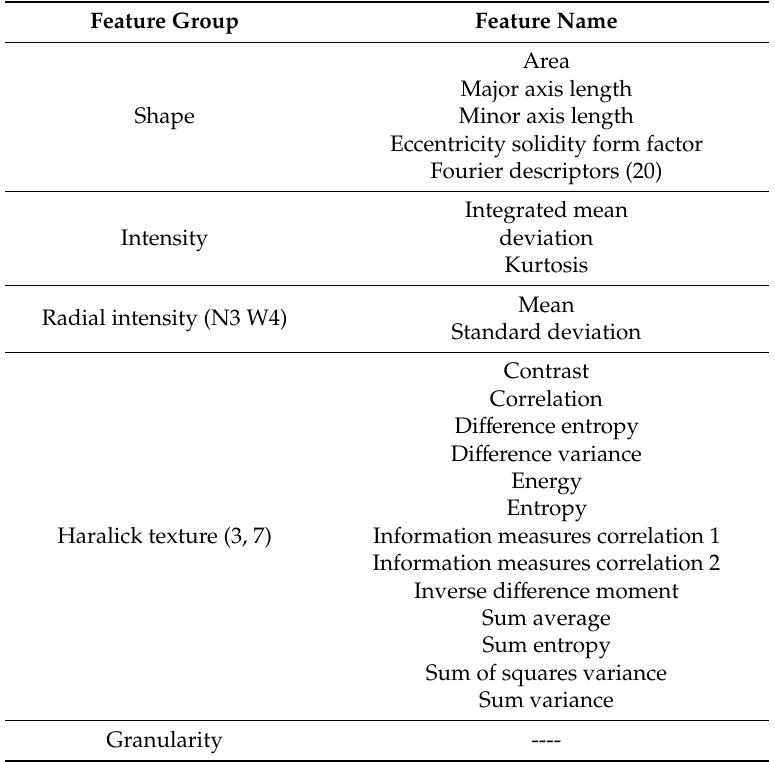
Table A1. List of Extracted